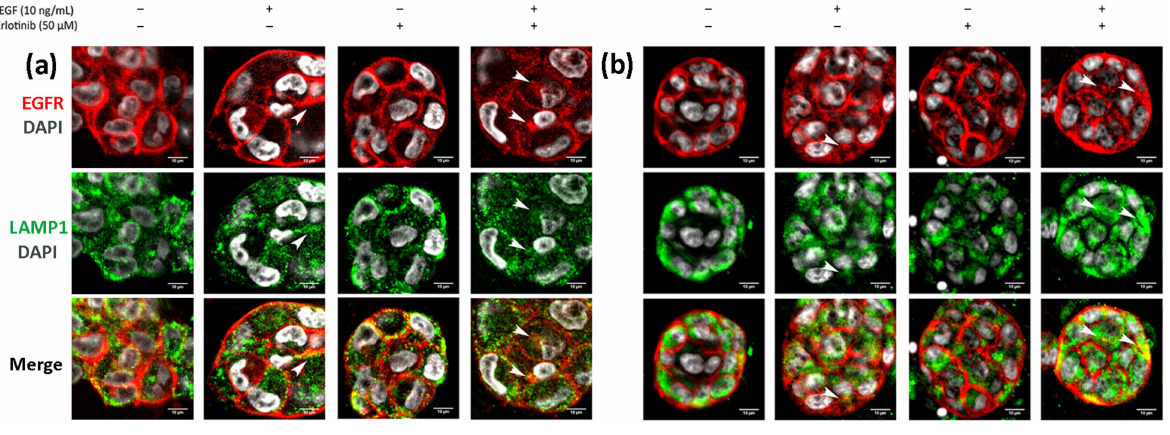
Figure 12. Immunofluorescence of EGFR and LAMP1 in ( a ) PANC-1 and ( b ) BxPC-3 cells incubated with EGF, erlotinib or both in 0.15% RAD16-I 3D cultures. One representative Z plane is shown. Scale bars represent 10 µ m. White arrows show EGFR colocalizing with